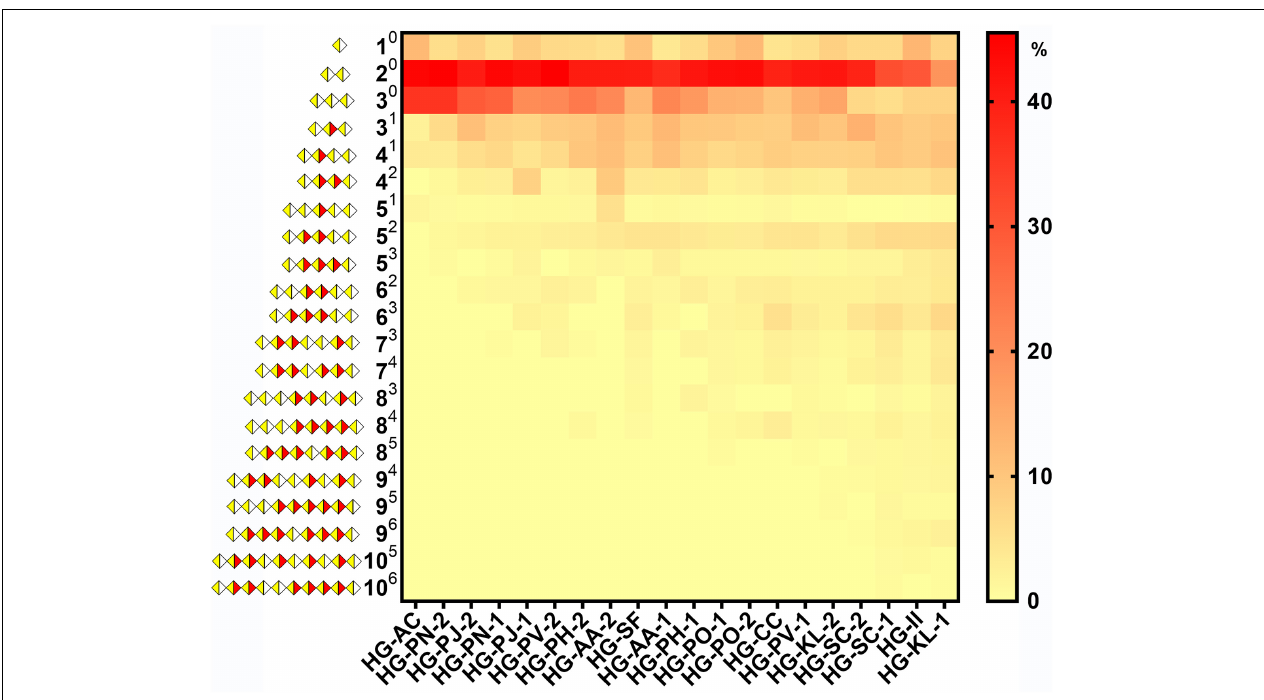
FIGURE 8 | The heatmap of species and quantification of HG pectin oligosaccharides in different plants (A B A is the degree of galacturonic acid; B is the number of methyl groups; GalA; methylesterified GalA).